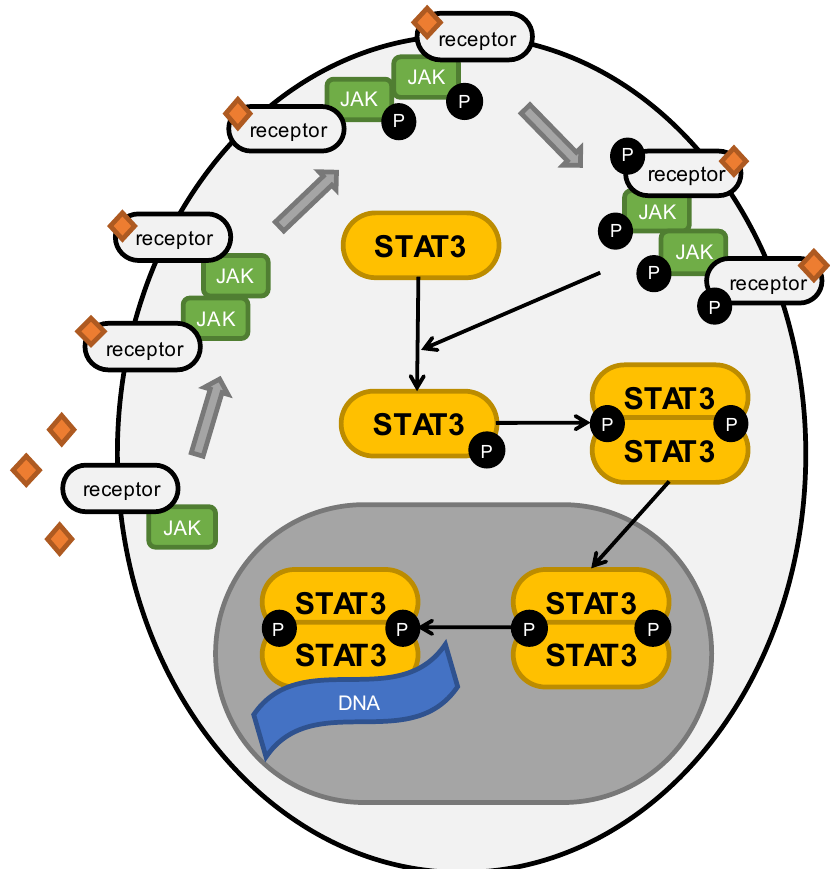
Figure 1. Schematic and simplified depiction of STAT3 pathway activation. Orange diamonds present ligands’ molecules, and black circles marked with “P” present phosphate group. Figure presents the process of receptor dimerization due to their activation by ligands, JAK transphosphorylation, receptors’ phosphorylation, STAT3 phosphorylation, STAT3 dimerization, translocation to the nucleus, and, finally, its binding to DNA.